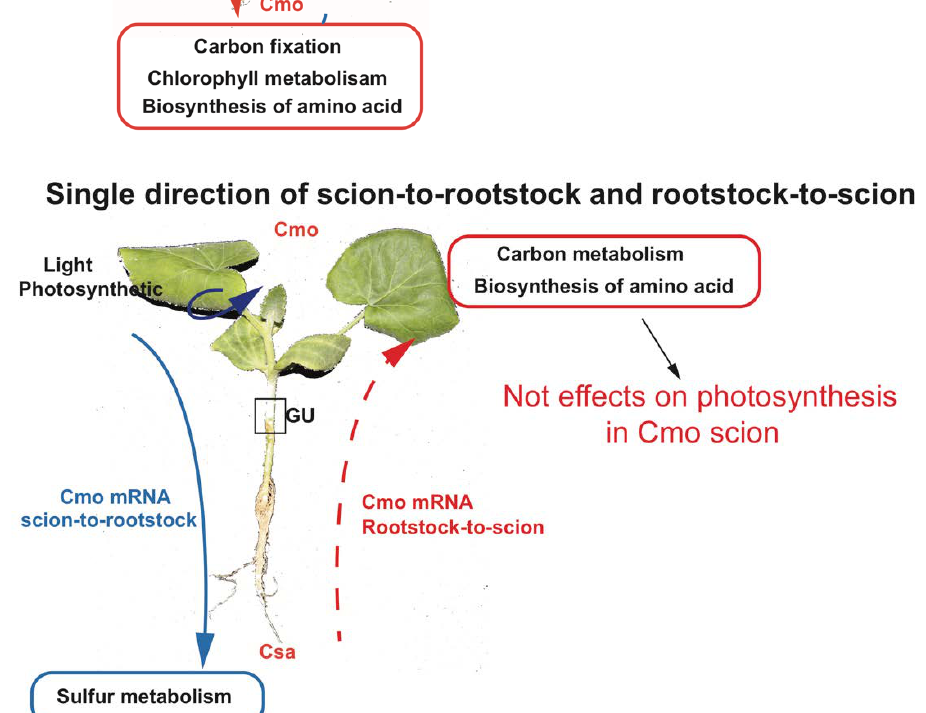
Figure 10. Scheme of Csa and Cmo mRNA movement pathways between pumpkin and cucumber. In the upper panel of cucumber scion grafted onto pumpkin rootstock, the majority of Csa mRNAs relating to photosynthetic are transported into the root of pumpkin, following the major flow of sucrose in the phloem from source leaves to the root in hypocotyl-grafted Csa / Cmo seedlings. Pumpkin rootstock produced rootstock-to-scion axis Cmo mRNAs related to carbon metabolism, chlorophyll metabolism, and amino acid synthesis are migrating into shoot tissues by unknown mechanism or cell-to-cell spreading after grafting union of young seedlings (a few centimeters), thereby increasing cucumber chlorophyll metabolism to enhance photosynthesis. It forms a closed loop of scion-to-rootstock-to-scion feedback. In the lower panel of pumpkin scion grafted onto cucumber rootstock, Cmo mRNAs associated with the photosynthetic produced in pumpkin leaves are transported into cucumber roots; however, cucumber rootstock does not respond correspondingly, thus does not deliver Csa mRNAs to effect on photosynthesis of Cmo scion, representing the single directional pathways of scion-to-rootstock and rootstock-to-scion. Csa, Cucumis sativus ; Cmo, Cucurbita moschata .